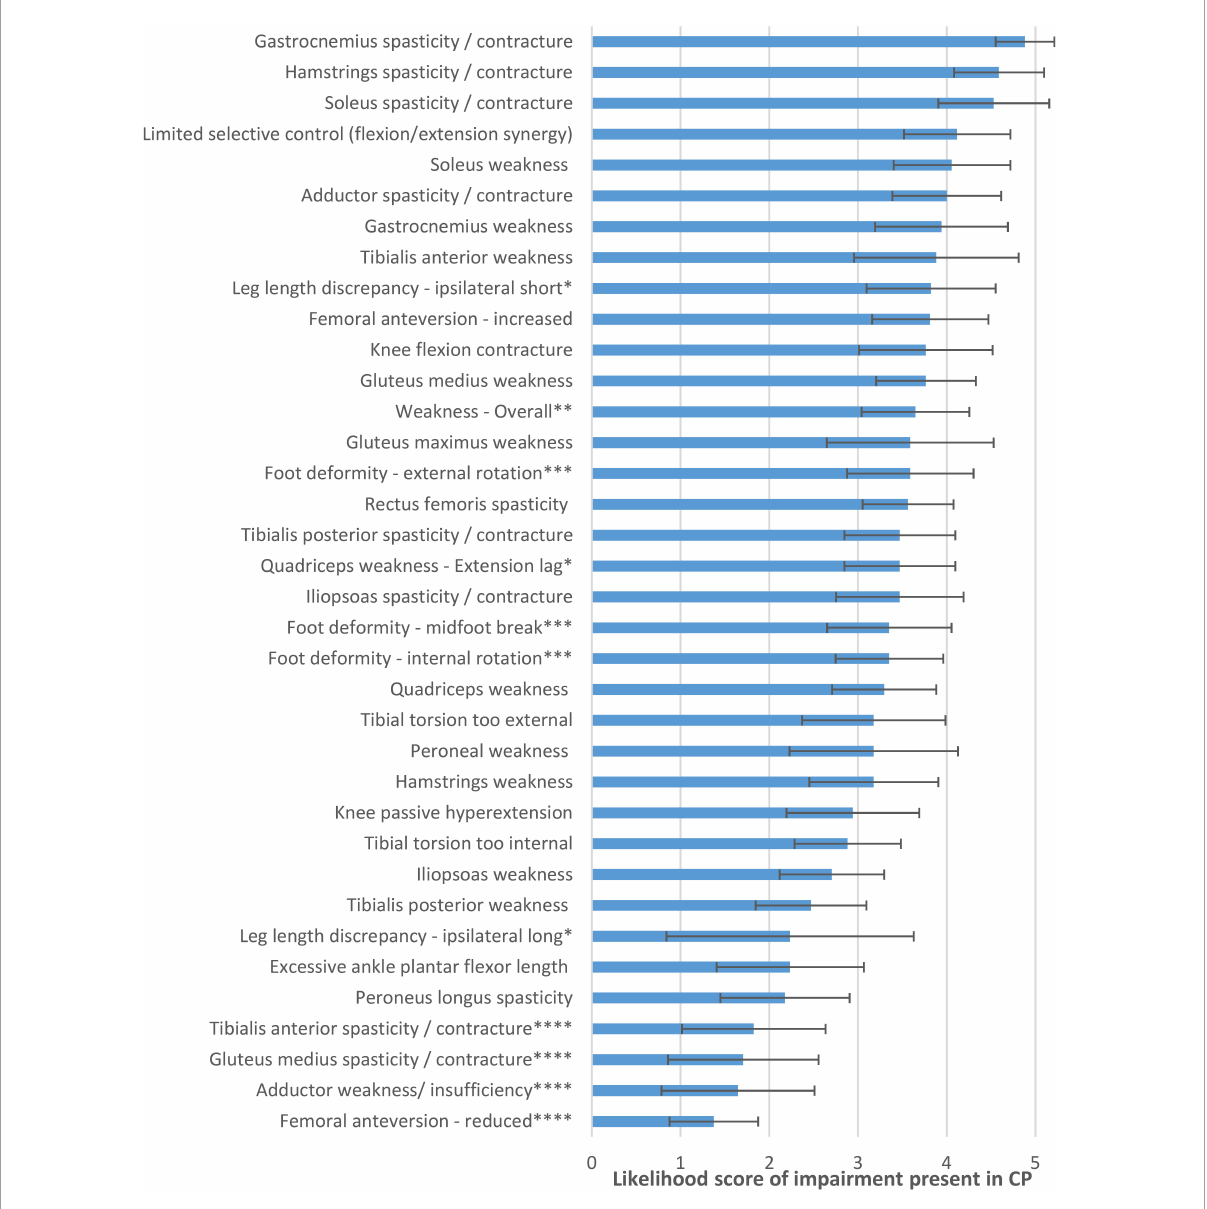
FIGURE2 Likelihood of impairments being present in CP, as judged by the expert panel in questionnaire 2. ∗ Reworded in final list to “Leg length discrepancy, shortest/longest leg.” ∗∗ Excluded in final list, as too general to be coupled with specific gait features. ∗∗∗ Reworded/combined in final list, to “Foot deformity” only. ∗∗∗∗ Excluded in final list, as very unlikely in